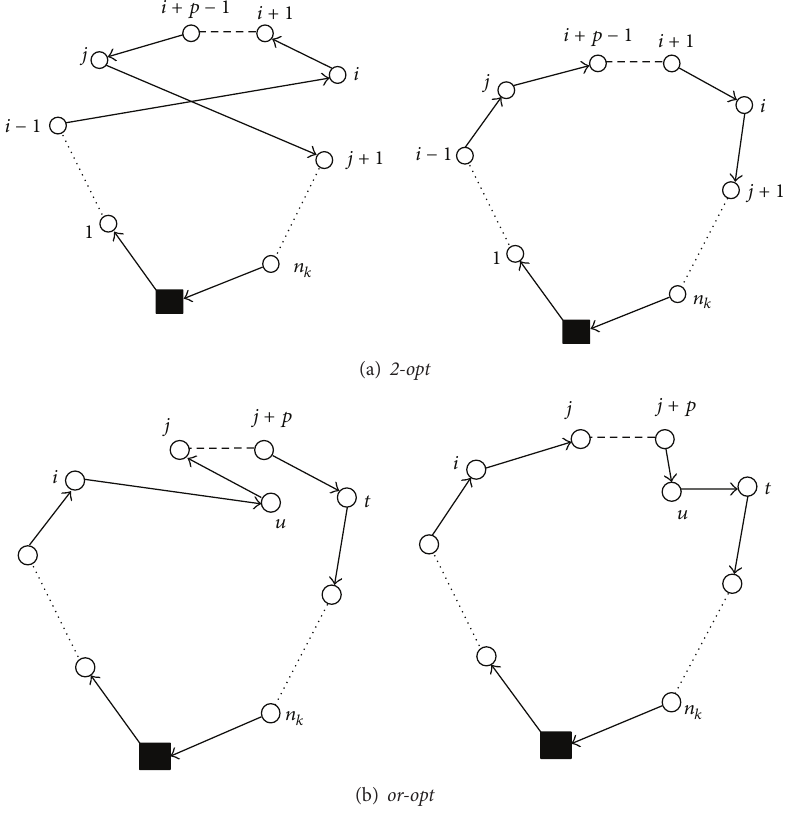
Figure 3: The 2-opt and or-opt operations.